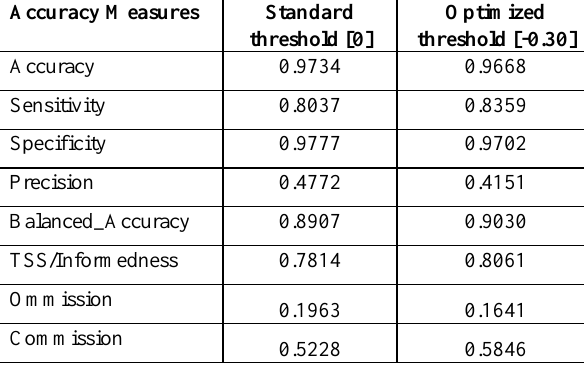
Table 1. Accuracy measures for the standard and optimised